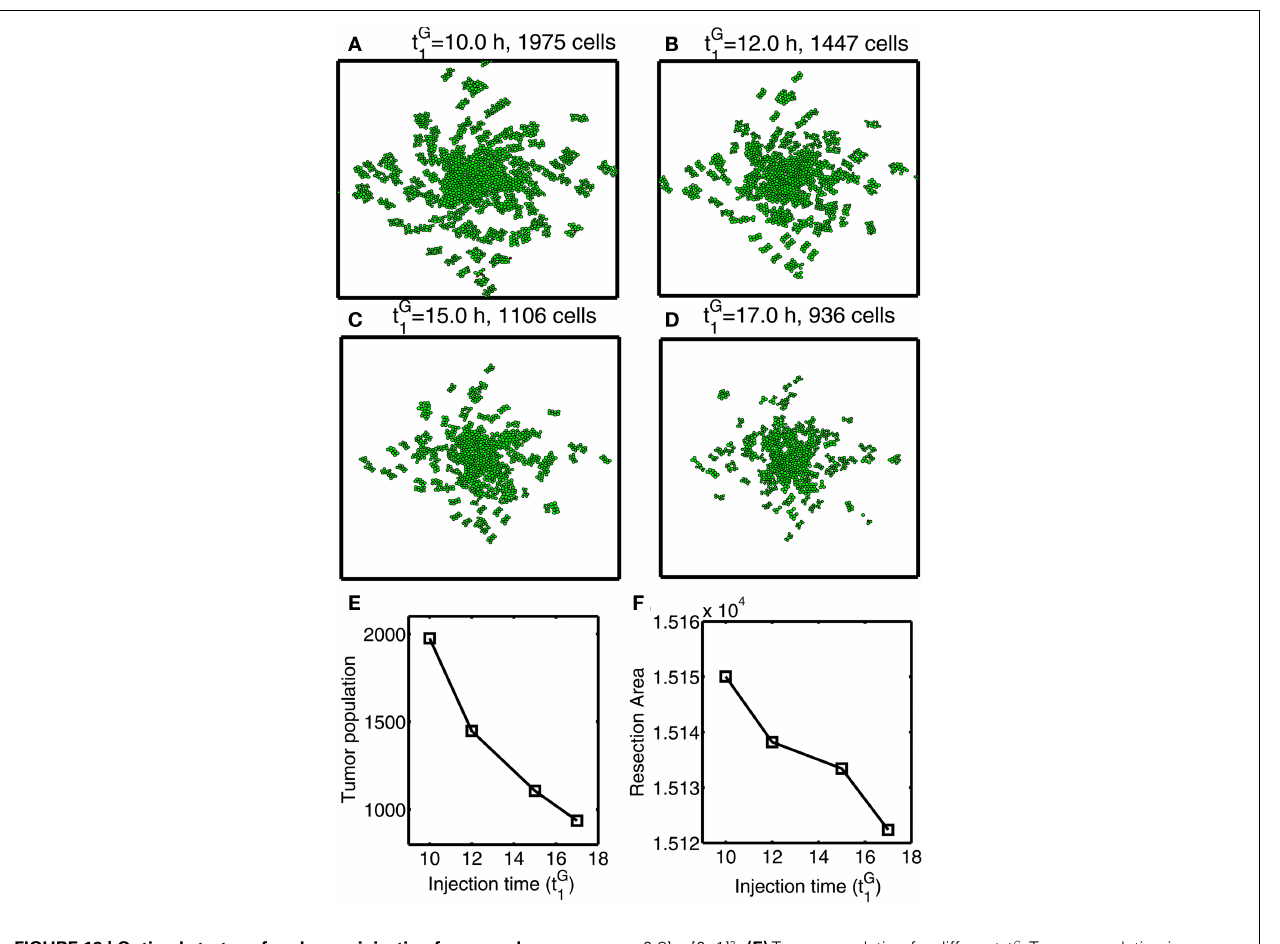
FIGURE 12 | Optimal strategy for glucose injection for second surgery after attracting invasive cells via chemotaxis. (A–D) Growth patterns at final time ( t = 33h) for various glucose injection time ( t G = 10 ( A ) ,12 ( B ) ,15 ( C ) ,17 h ( D )) . Domain size = [0 . 2, 0 . 8] × [0 . 2, 1